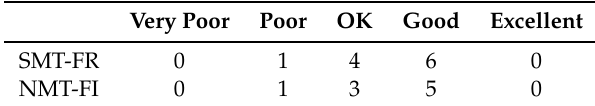
Table 5. Answers to the last question: What is your assessment of the quality of the machine translation output you are currently provided with in DGT, as related to your professional translation needs: very poor, poor, OK, good,